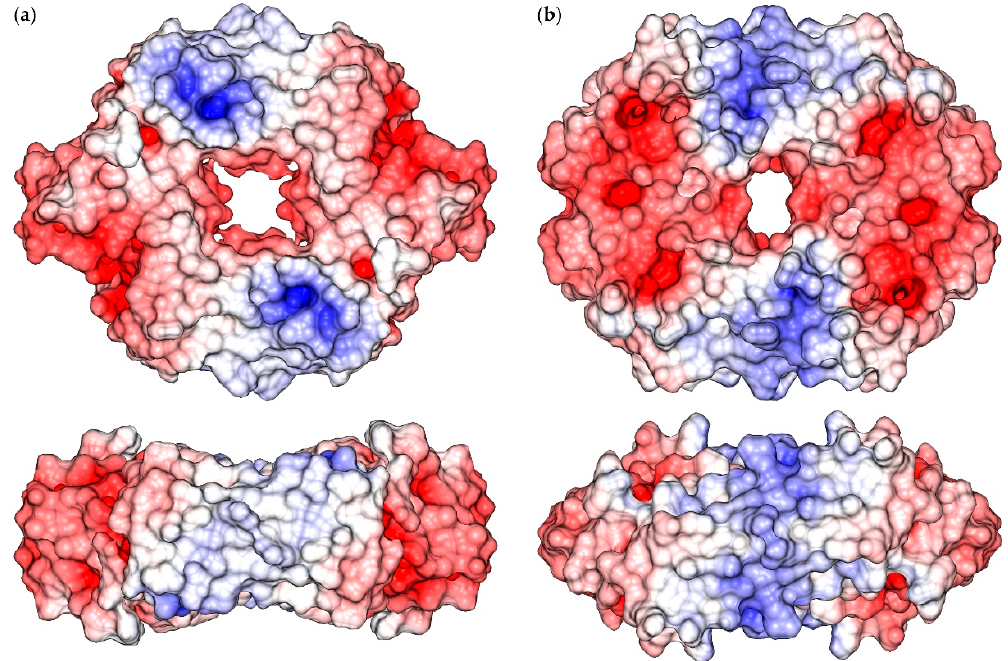
Figure 4. Molecular surface of apo- Sy InrS ( a ) and holo- Sy InrS ( b ). The surface is coloured according to the surface electrostatic potential calculated with APBS software [26]. The orientations in the bottom panels are rotated by 90° around the horizontal axis with respect to the orientations in the top panels.